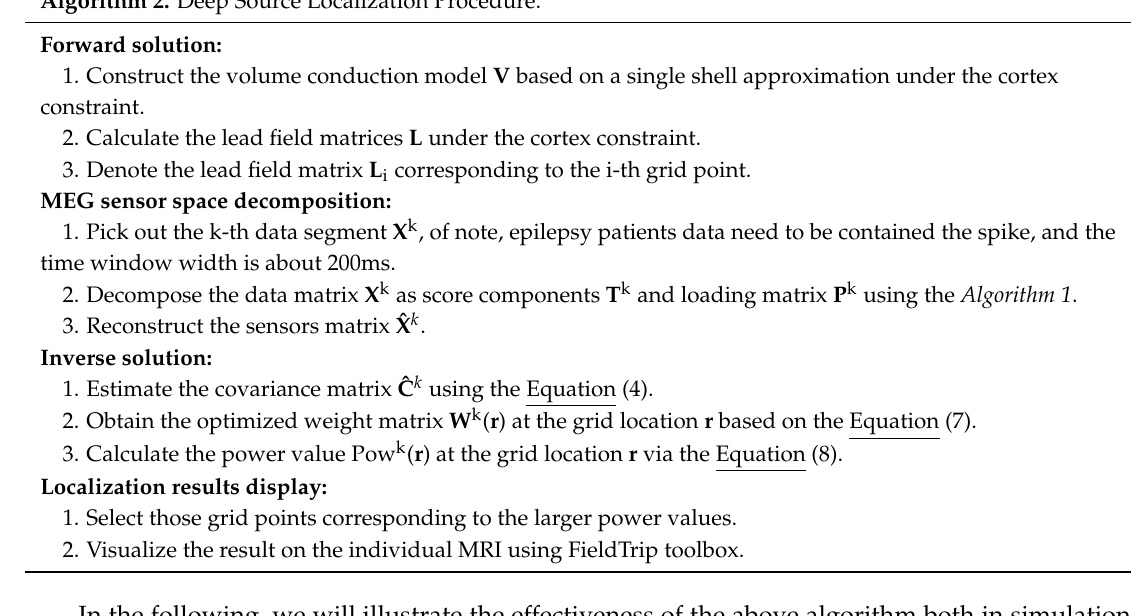
Algorithm 2. Deep Source Localization